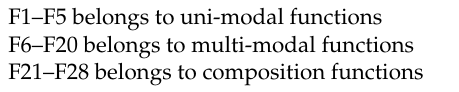
Table 2. The CEC2013 benchmark